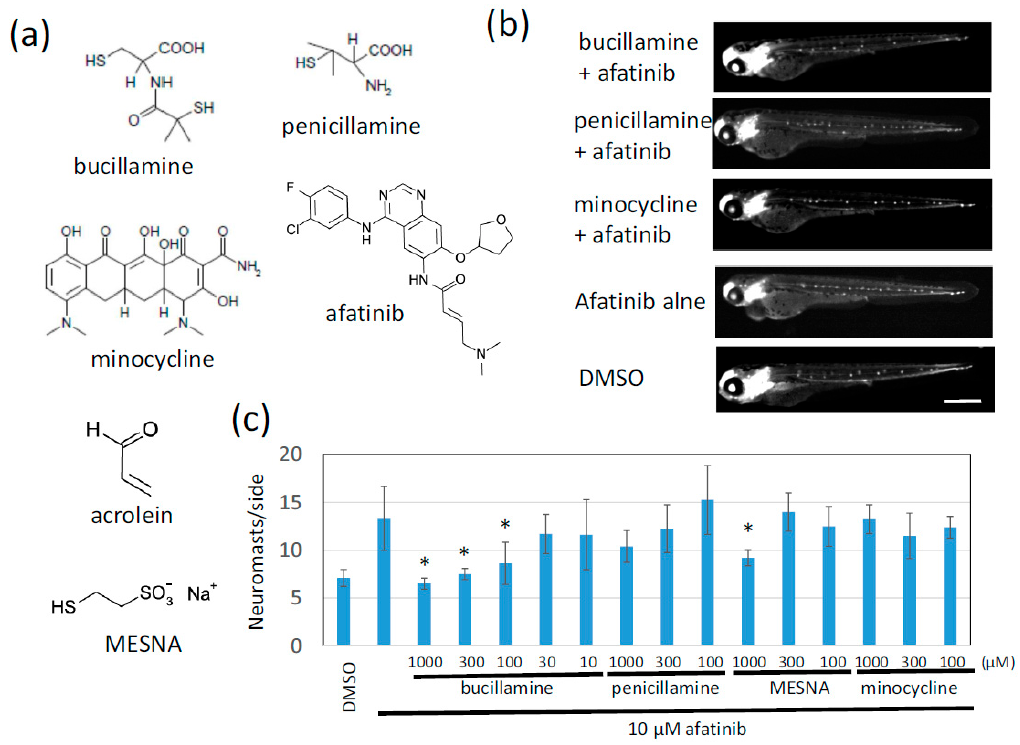
Figure 2. Bucillamine, an antirheumatic drug, suppressed afatinib-induced extra lateral line neuromast development. ( a ) Structures of the test compound, acrolein, and MESNA are shown. ( b ) Clinically available sulfhydryl compounds were evaluated for afatinib quenchers. Neuromasts of 72 hpf larvae treated with the indicated test compound were detected by fluorescence of cldnb : gfp . Scale bar = 500 µ m. ( c ) The number of neuromasts on one side were counted. The graph indicates the mean ± SD ( n = at least 4). * p < 0.01; MESNA, sodium 2-mercaptoethanesulfonate; hpf, hours postfertilization; SD, standard deviation.